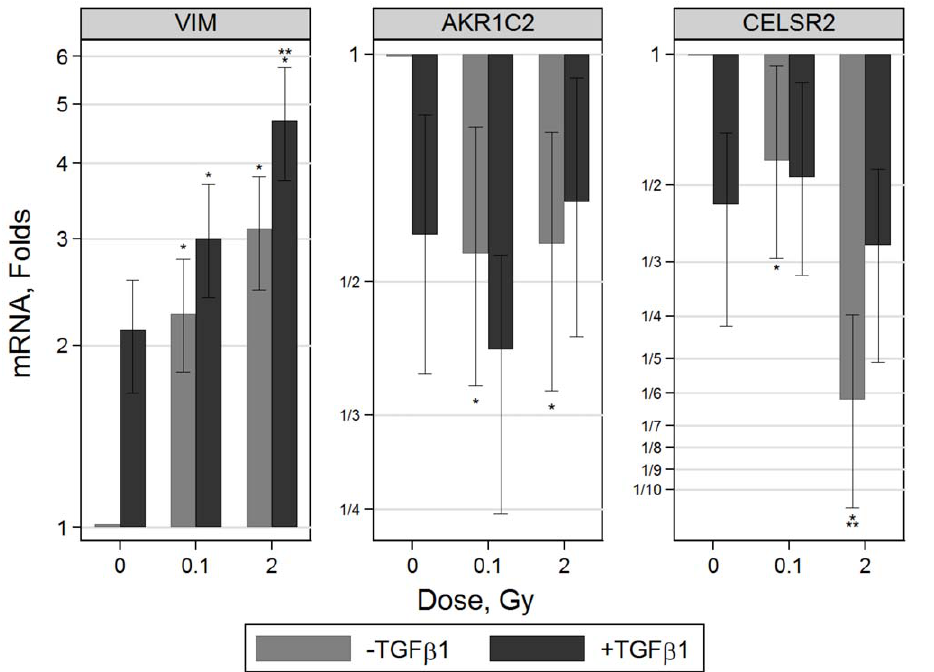
Figure 5. Alterations of gene expression related to EMT in proton-irradiated EPC cells, with or without TGF b 1 treatment. mRNA level of VIM was significantly up-regulated 3 days after treatment with TGF b 1, and a further increase was achieved when cells were irradiated with protons in the presence of TGF b 1, in a dose-dependent manner. AKR1C2 and CELSR2 were down regulated in single or double treated cells. Shown are results from two independent proton experiments with 6 real-time PCR measurements in total. Single asterisks indicates that there is significant difference (p-value , 0.05) compared to 0 Gy untreated cells. Double asterisks indicate that the mRNA level following 2 Gy of protons is significantly different compared to 0.1 Gy. Error bars represent 95% CI